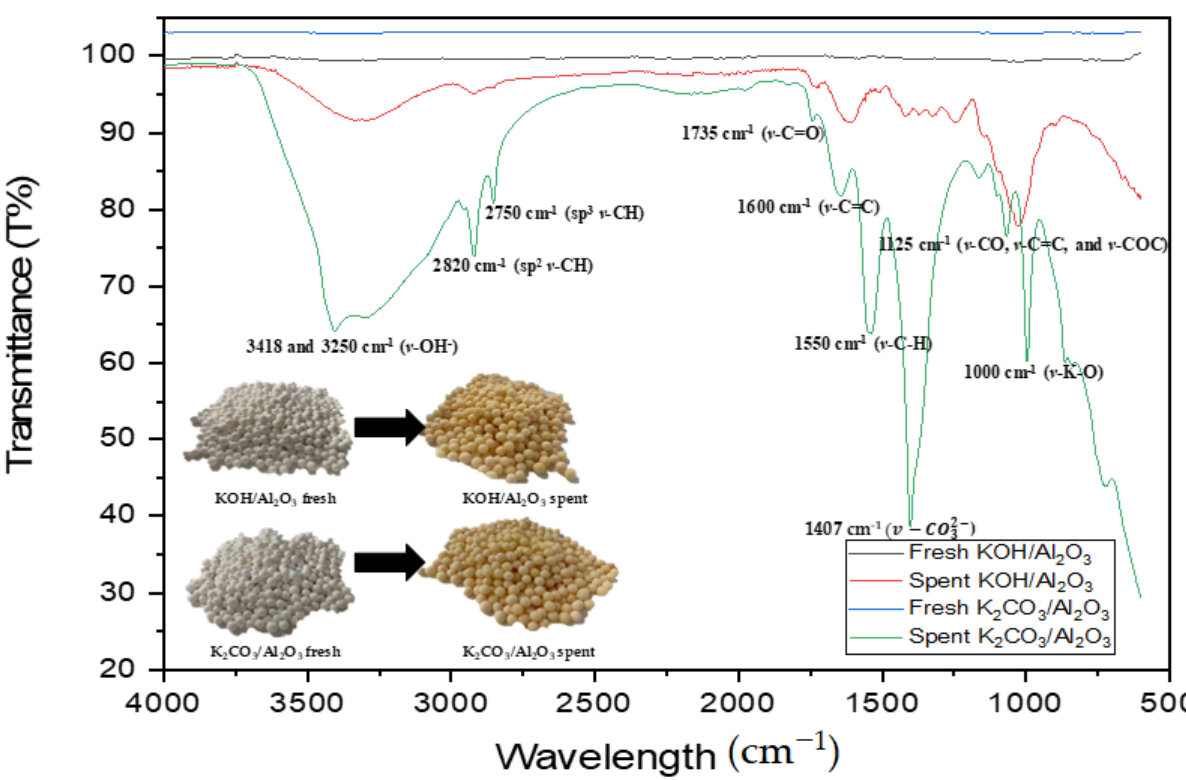
Figure 9. FTIR spectrum of fresh KOHAl 2 O 3 catalyst; fresh K 2 CO 3 /Al 2 O 3 catalyst; spent beads K 2 CO 3 /Al 2 O 3 catalyst; and spent beads KOH/Al 2 O 3 catalyst.